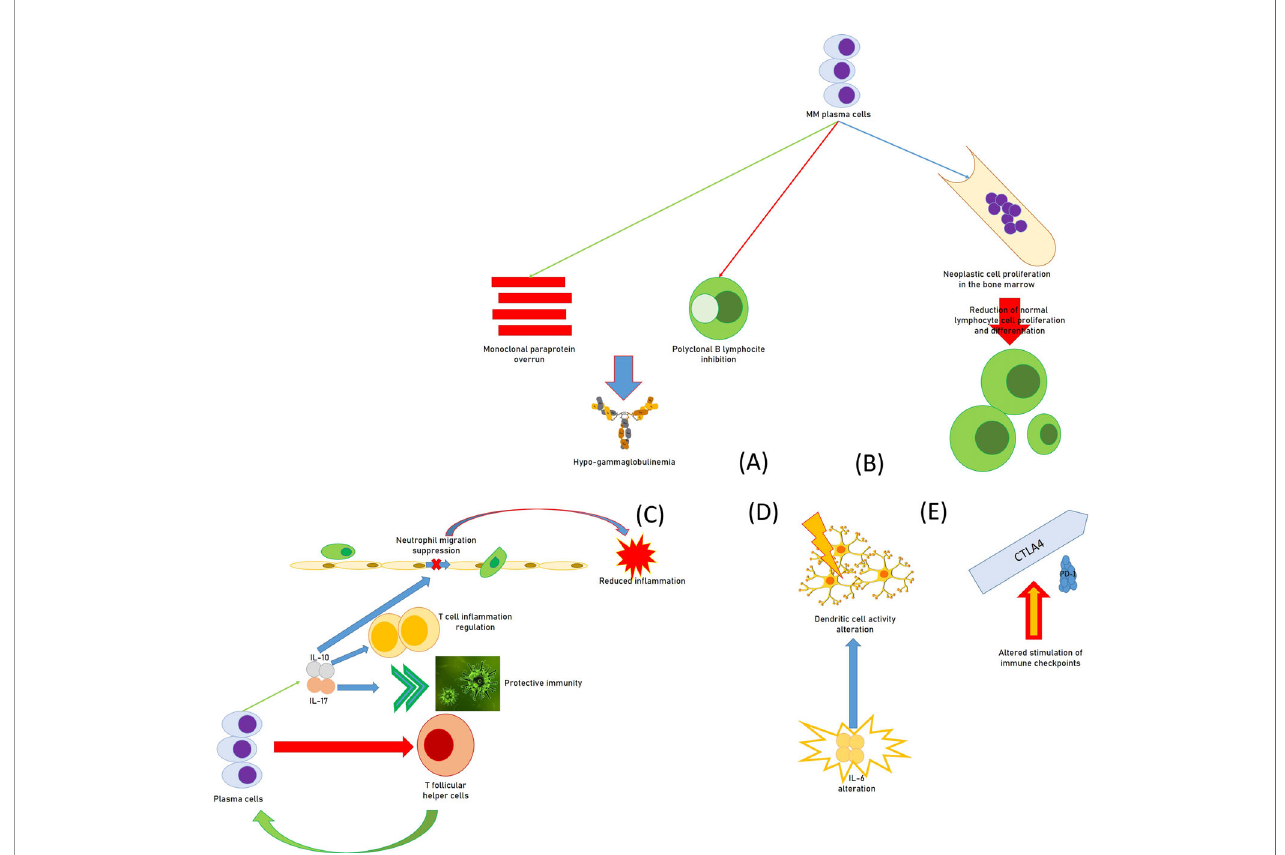
FIGURE 1 | Causal moments of immunode fi ciency in patients with multiple myeloma: (A) functional hypogammaglobulinemia; (B) de fi cit of the proliferative attitude of lymphocytes; (C) regulation of immune functions by plasma cells, with the reduction of T follicular helper cells, the promotion of IL-17, increasing protective immunity against some infections, the source for IL-10, in turn regulating T-cell-related in fl ammation and suppressing neutrophil-related in fl ammation; (D) alteration of the activity of the dendritic cells by huge immune alterations, including IL-6; (E) alteration of the immune checkpoints (altered stimulation of CTLA-4 and PD-1) provoking immunode fi